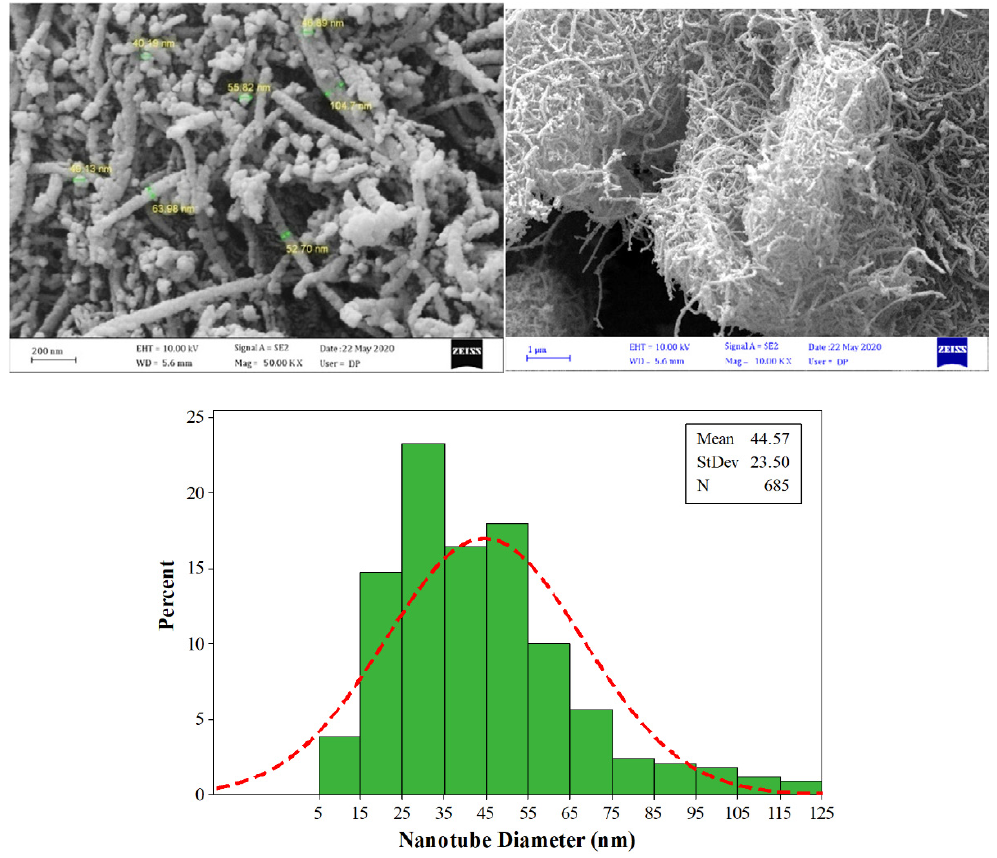
Fig. 3. (a,b) SEM micrograph of (MWCNTs)-COOH/La 2 O 3 nanocomposite, (c) Nanotubes outer diameter